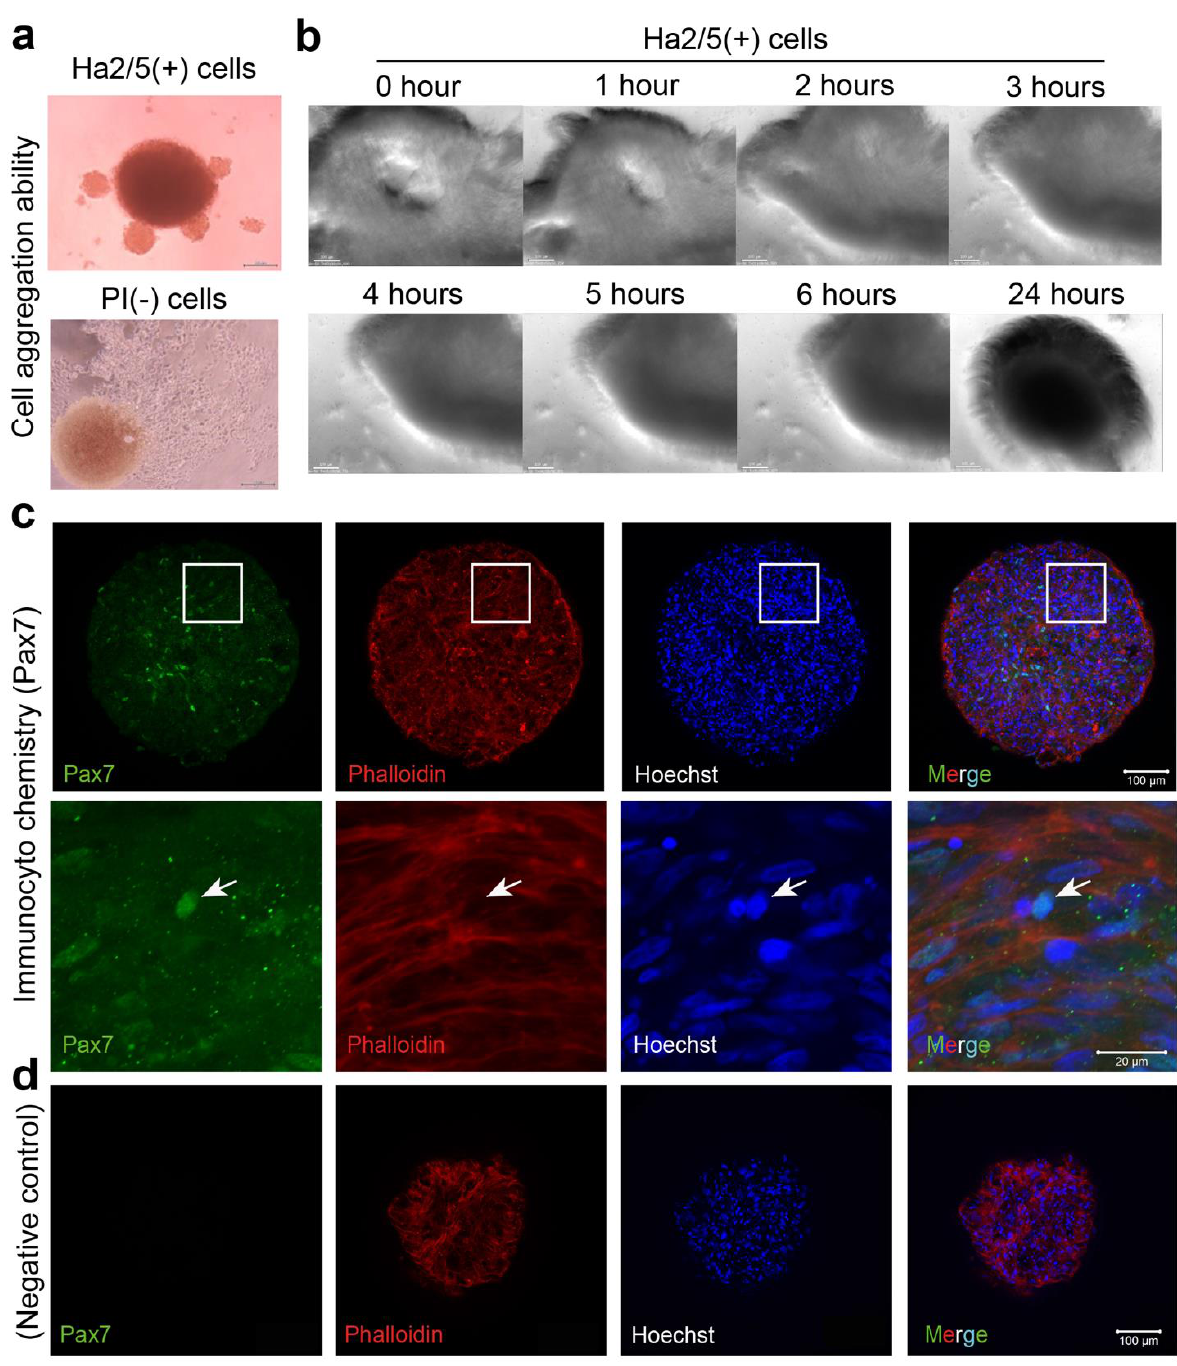
Figure 3. An analysis of the spheroid-forming capacity of Ha2/5+ cells. ( a ) Ha2/5 cells (1 × 10 5 ) were seeded in 96-well round-bottom plates, centrifuged at 400 × g , and then cultured for 24 h. Ha2/5+ cells and unpurified cells (all living cells) were seeded, and photomicrographs taken one week later are shown. The scale bar represents 200 μm. The brown mass (in PI-negative cells) was hematopoietic cells. ( b ) Images of spheroid-forming cells at 0, 1, 2, 3, 4, 5, 6, and 24 h after seeding the cultured Ha2/5 cells. ( c ) Analysis of Ha2/5 spheroids by immunostaining. Muscle marker: Pax7 are shown in green. Cyto-skeletal marker (Phalloidin, red) and cell nuclei (Hoechst, blue) are shown. The white square is enlarged on the lower panel. Allowhead indicate the localization of Pax7. ( d ) Negative controls in Pax7 staining were displayed. The scale bar represents 100 µ